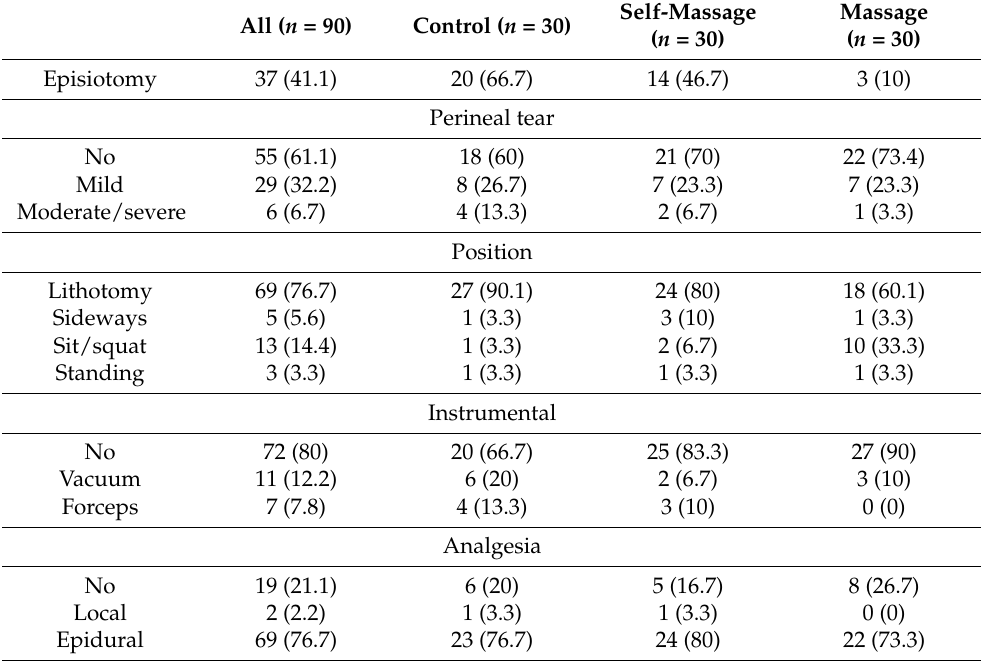
Table 2. Delivery characteristics [data provided: n (percentage)].